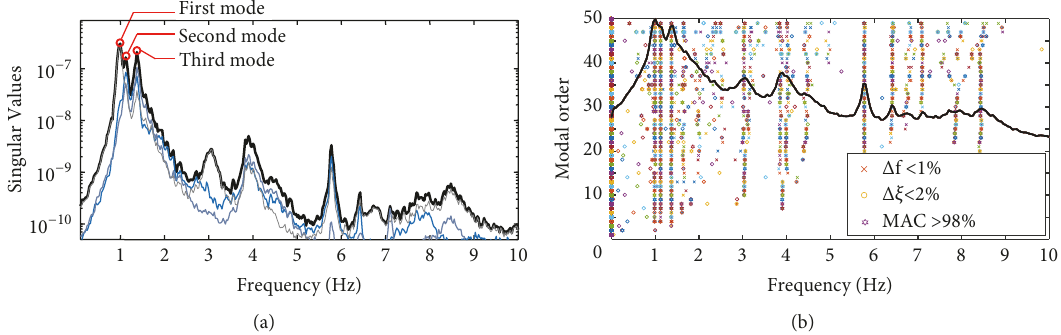
Figure 9: (a) Singular-Value Decomposition plot and (b) typical stabilization diagram of an